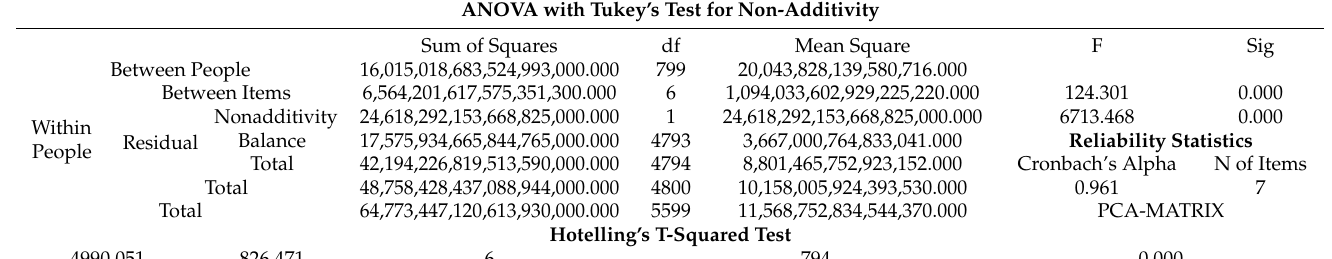
Table 4. Results of sustainable profit factor in business through reliability analysis.